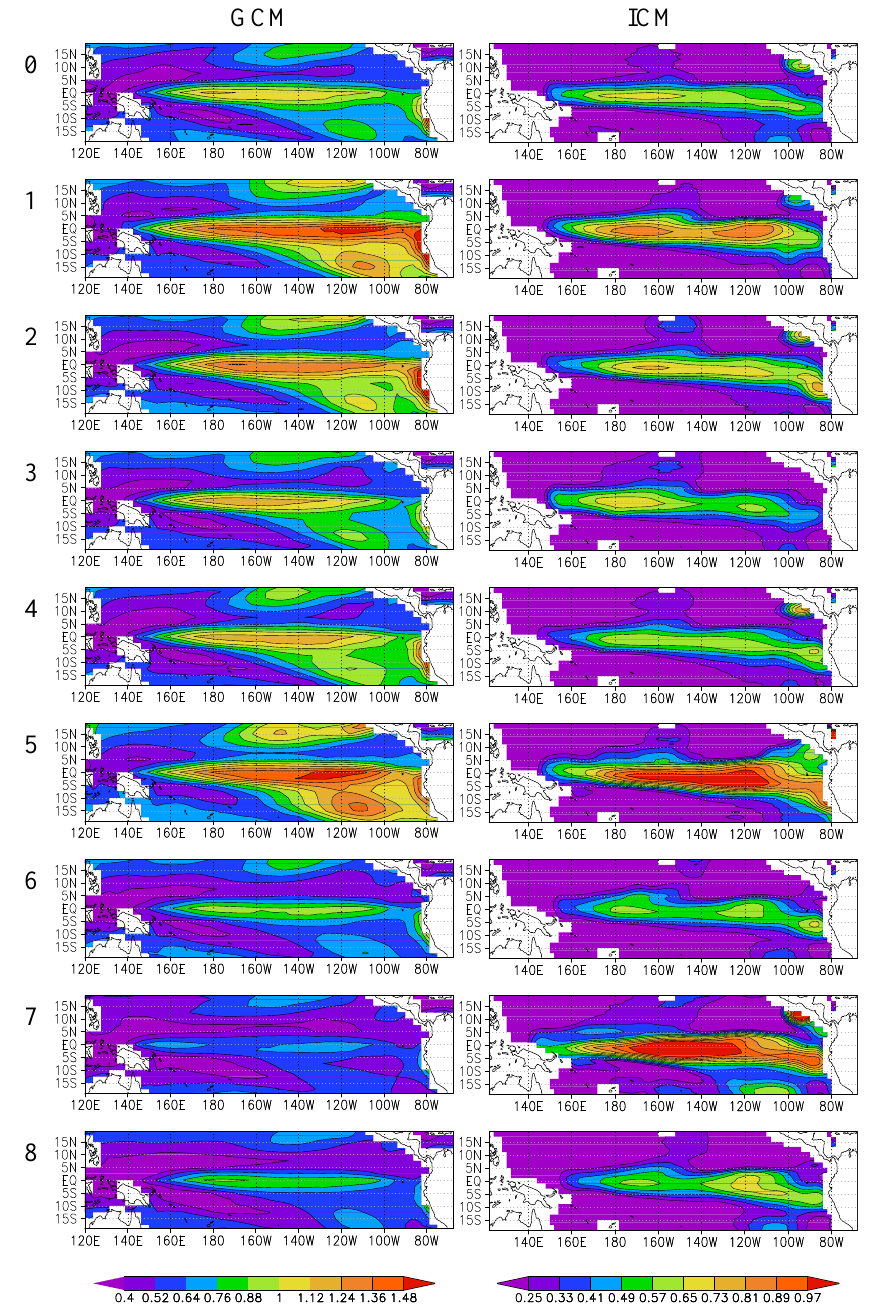
Fig. 8a. Pattern of SST standard deviation for GCM ensemble members (left) and corresponding full ICM runs (right): STAM-member and ATM-members 1–9. Note the factor of 2/3 difference in scale.